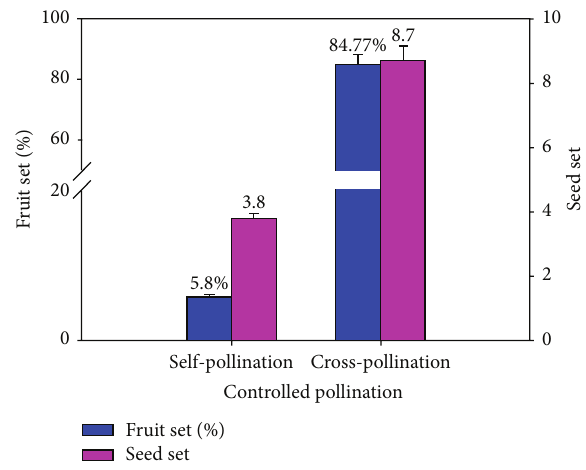
Figure 6: Percentages of fruit set and seed set of “Hongpisu” after controlled